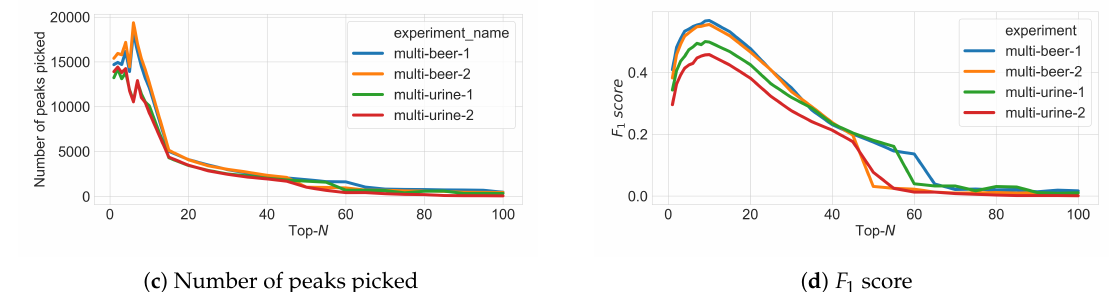
Figure 5. Figures showing ( a ) precision, ( b ) recall, ( c ) the number of peaks picked, and ( d ) F 1 score for peak picking performance as N changes in Top- N DDA experiments in ViMMS based on the classification specifications given in Figure